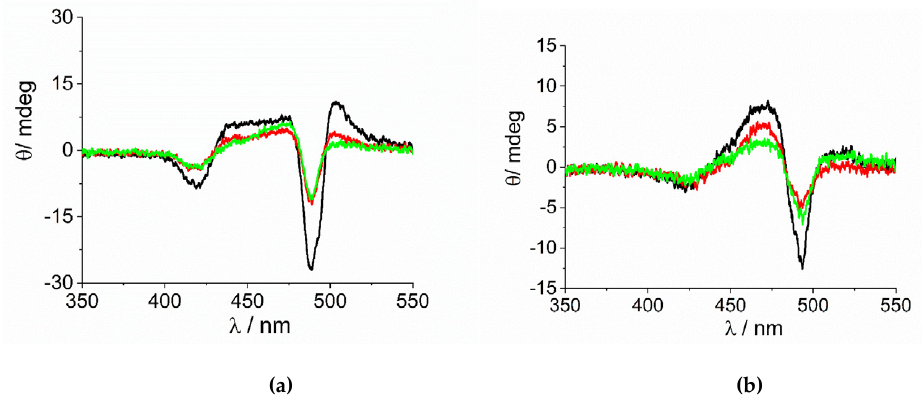
Figure 5. CD spectra of the samples at the end of the aggregation process for the experiments at variable concentration of ( a ) [Co(phen) 3 ] 3+ and ( b ) [Co(NH 3 ) 6 ] 3+ (Experimental conditions: [H 2 TPPS 4 ] = 3 µM; [HCl] = 0.01 M, [CoL n3+ ]= 100 µM (black line), 200 µM (red line), 300 µM (green line), T = 298 K).